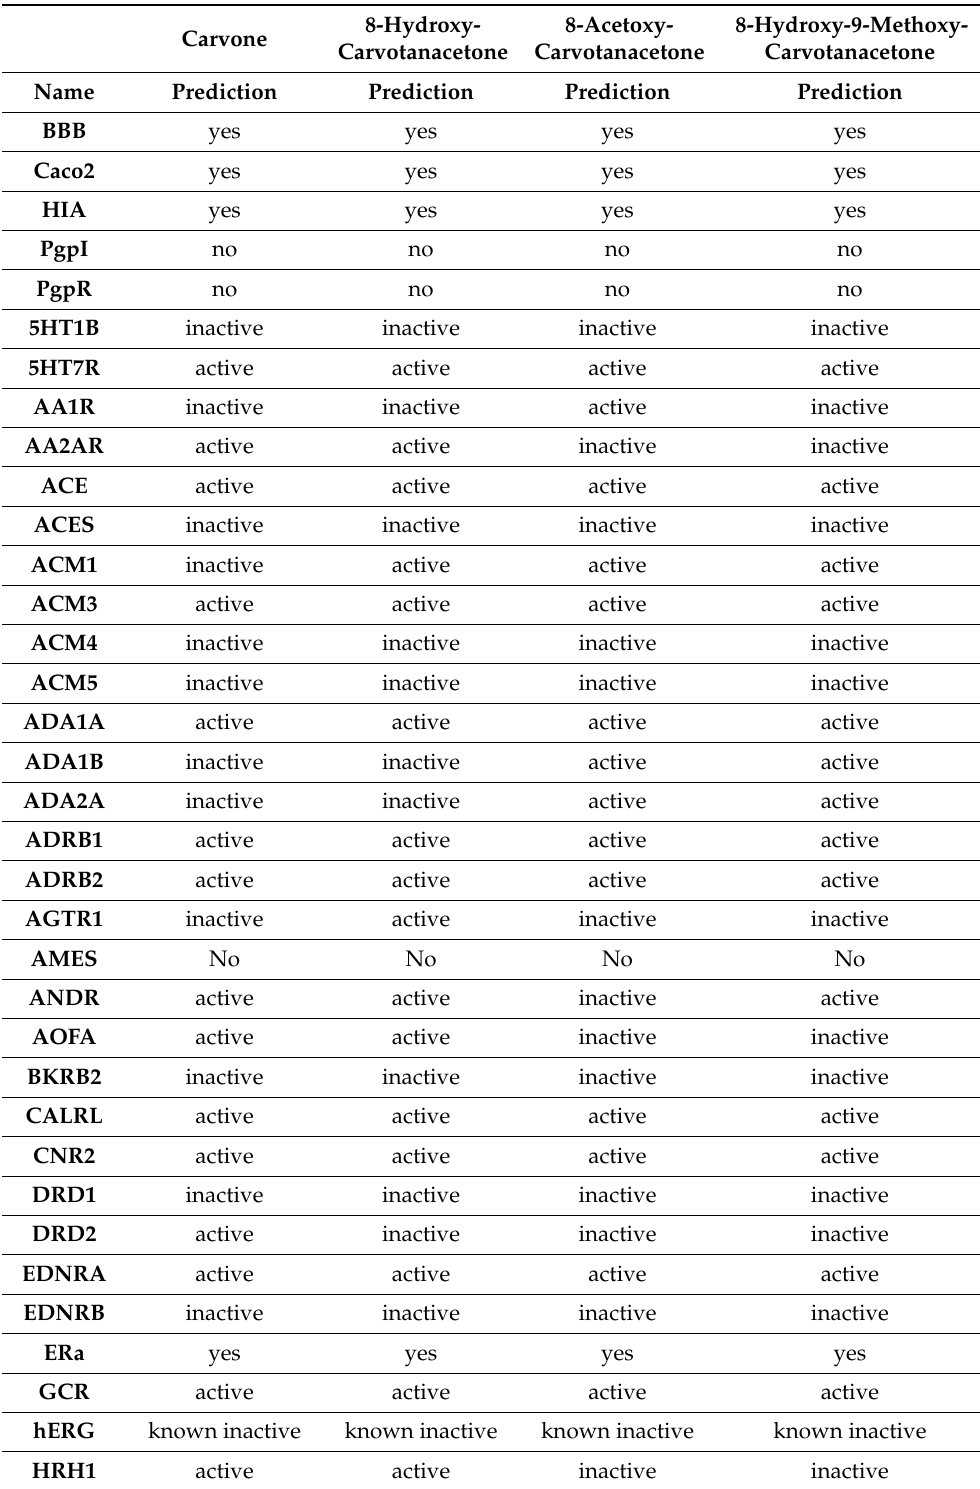
Table 1. Predictions relative to the permeability through the intestine and the blood–brain barrier (BBB) and the probability of interaction with important